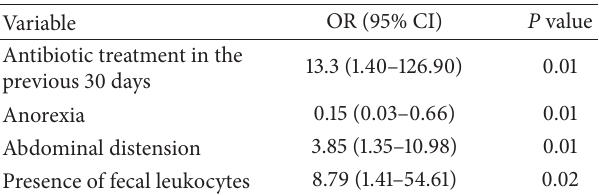
Table 3: Factors associated with Clostridium difficile infection among adult patients with hospital-acquired diarrhea according to multivariate logistic